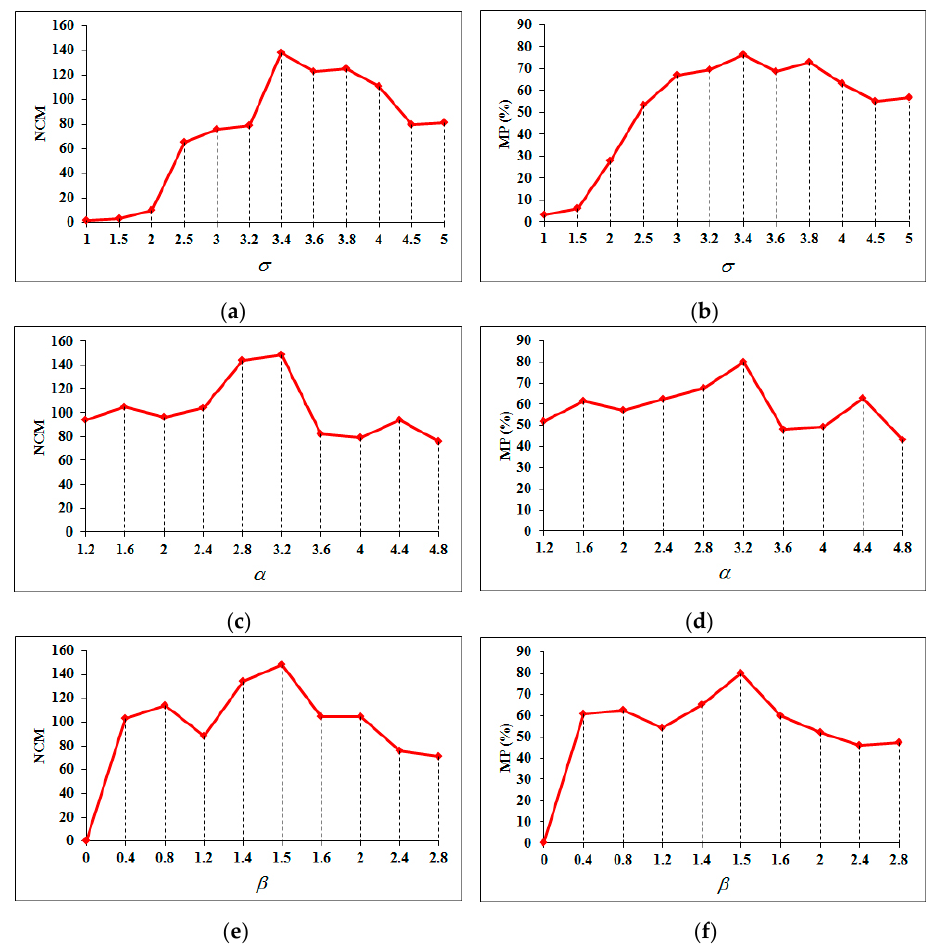
Figure 9. Experimental results of GGS bi-windows thresholds tuning. ( a , b ) are the test results of the criteria NCM and MP for different values of σ . ( c , d ) are the test results of the criteria NCM and MP for different values of α . ( e , f ) are the test results of the criteria NCM and MP for different values of β